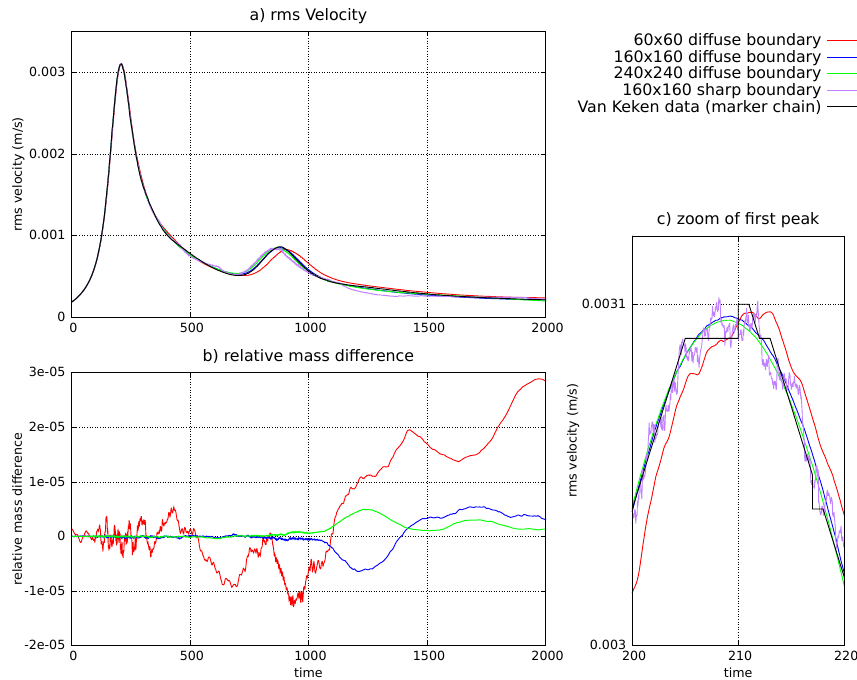
Figure 3. (a) Root mean square velocity of the entire domain. The Van Keken data is the data from the marker chain method of Van Keken from the original article. (b) The relative mass difference over time according to Eq. (12). (c) A zoom-in of the first peak in the rms velocity plot of (a)